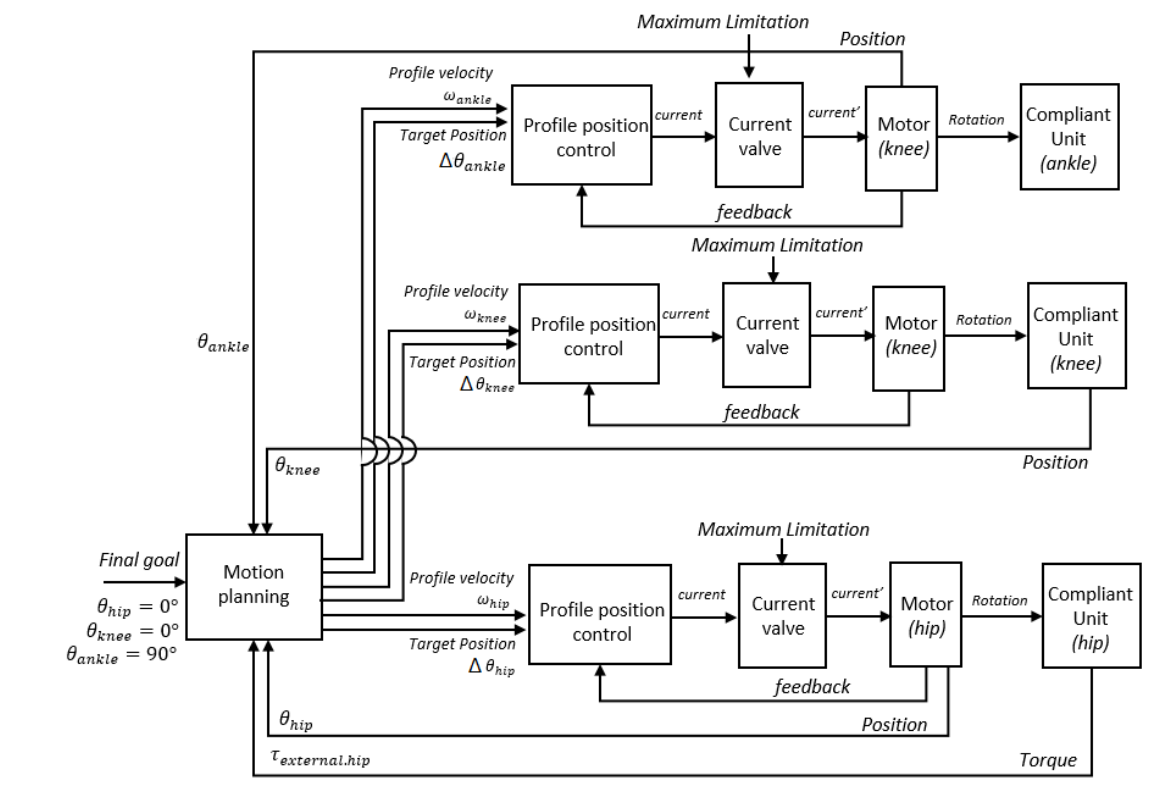
Figure 7. Proposed control method of STS